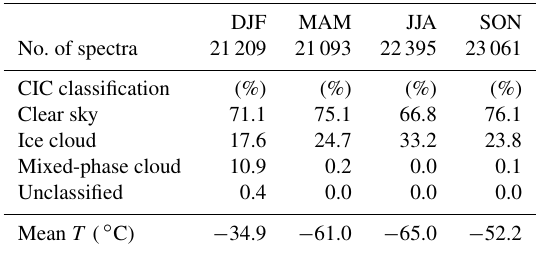
Table 5. Mean seasonal occurrences of clear sky, ice clouds, and mixed-phase clouds at Concordia Station. Mean surface air temper- atures are reported for each